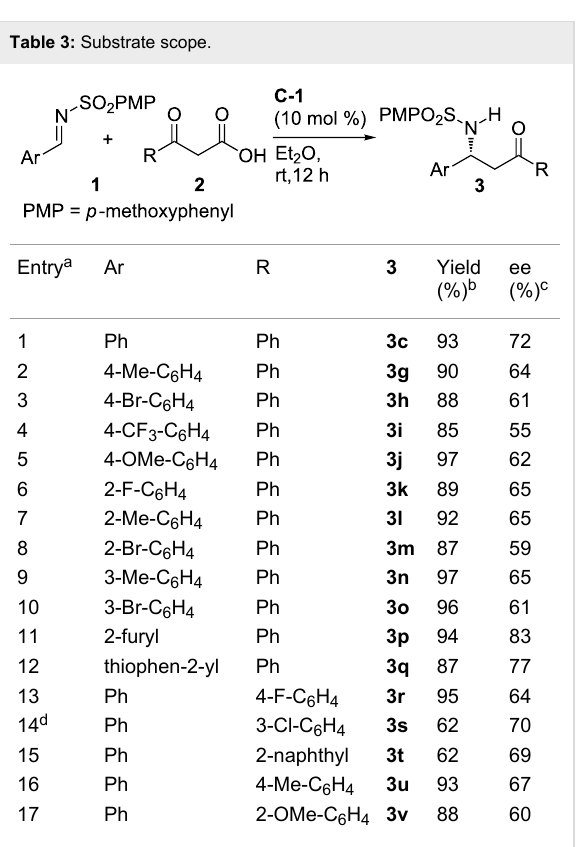
Table 3: Substrate scope.